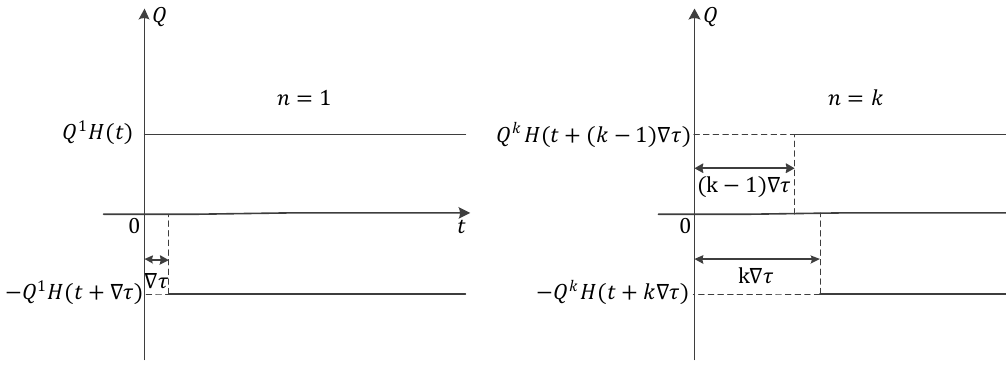
Figure 4. Periodic simple harmonic load excitation discretization. Figure 4. Schematic diagram of pule load formed by differential concentrated load.